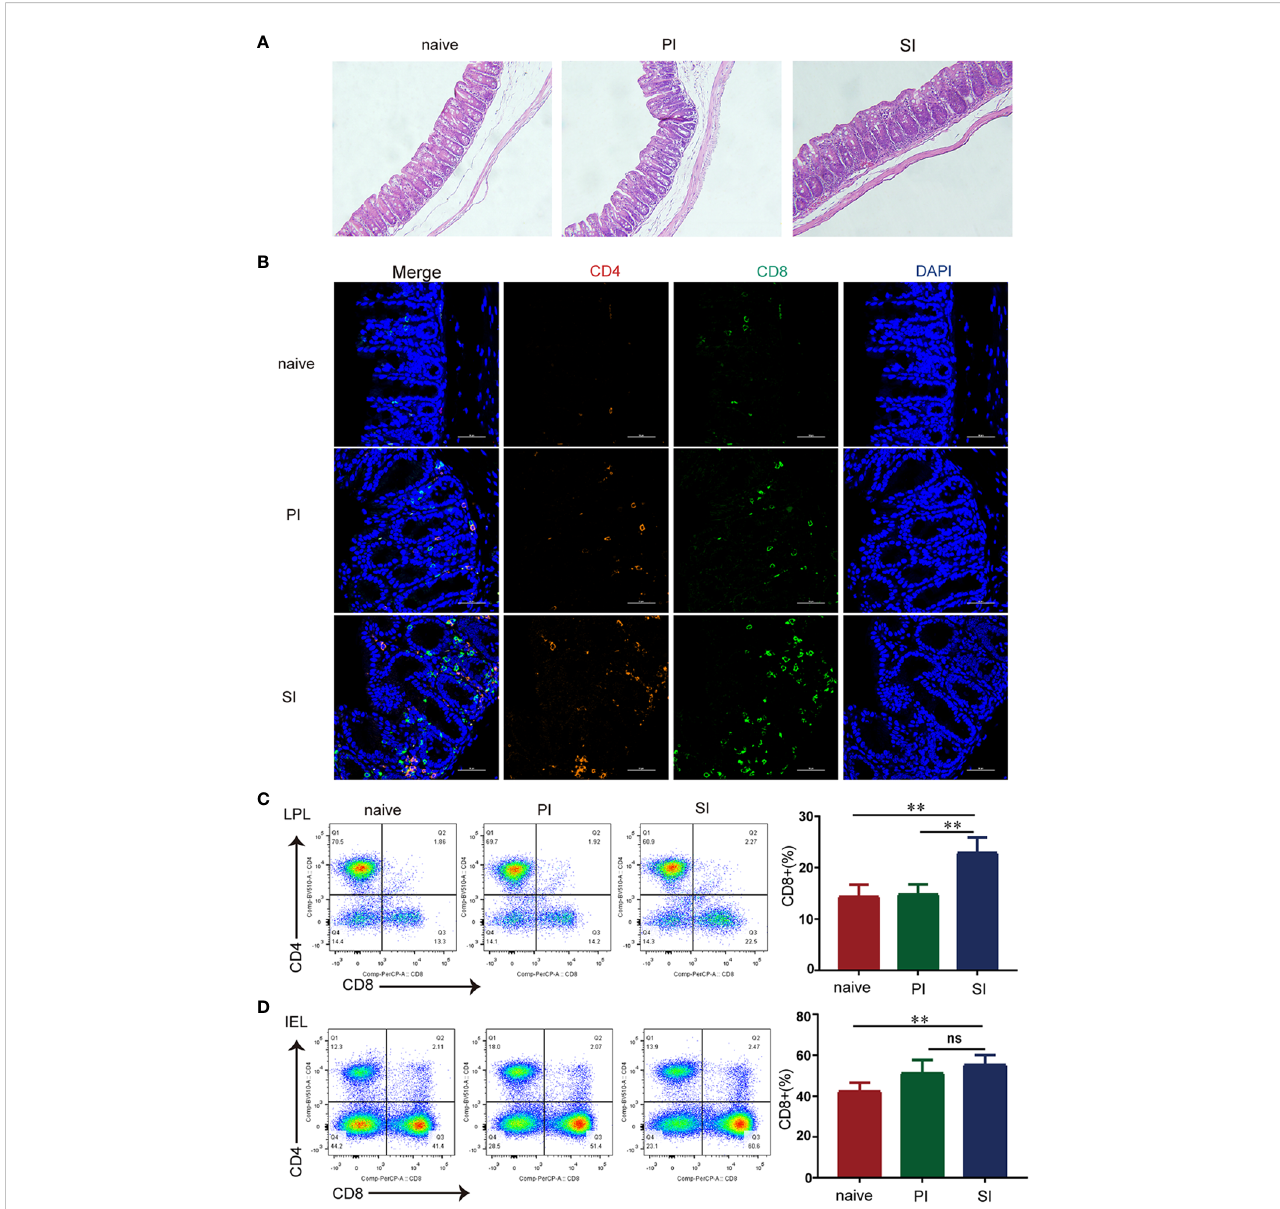
FIGURE 2 CD8 + T cells rose rapidly in the lamina propria of cecum after reinfection with E. falciformis . (A) H&E staining of cecum at 24 hours post primary infection and secondary infection with 5000 E. falciformis . n =3 per treatment group, magni fi cation ×200. (B) Multi-parameter immunohistochemical staining of cecal CD4 + and CD8 + T-cells in three groups after 24 h primary infection and reinfection. n =3 per treatment group, magni fi cation ×600. (C) Flow cytometric for expression of CD4 + and CD8 + on CD3 + T cells in IEL of cecum at 24 hours after primary infection and reinfection with 5000 E. falciformis . n =6 per treatment group. (D) Flow cytometric for expression of CD4 + and CD8 + on CD3 + T cells in LPL of cecum at 24 hours after primary infection and reinfection. n =6 per treatment group. Results are mean ± SD from three independent experiments, ns, no statistical signi fi cance, ** p ≤ 0.01, PI, primary infection; SI, secondary